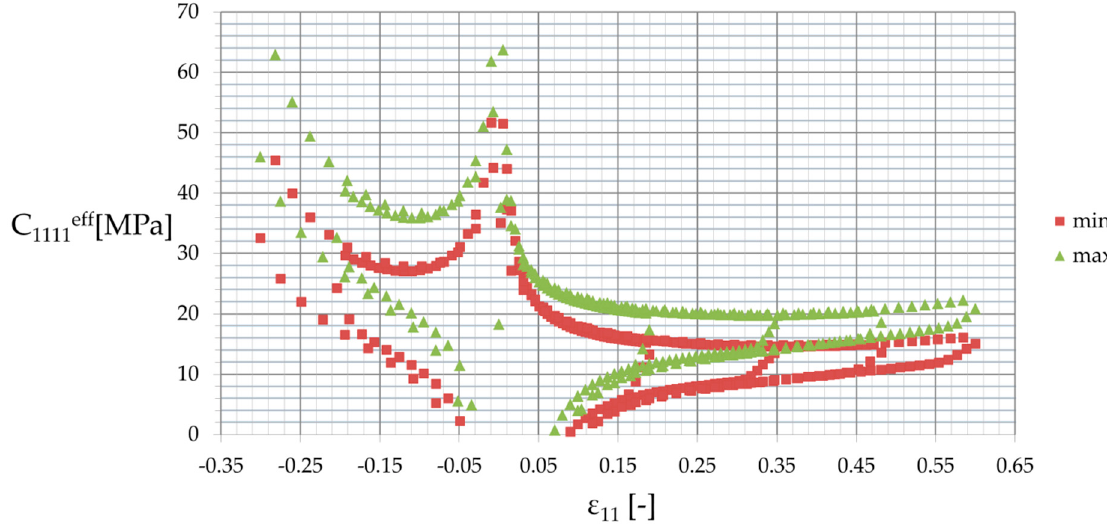
Figure 8. Effective stiffness of the polymer 𝐶 (cid:2869)(cid:2869)(cid:2869)(cid:2869)(cid:3032)(cid:3033)(cid:3033) with respect to strain 𝜀 (cid:2869)(cid:2869) .